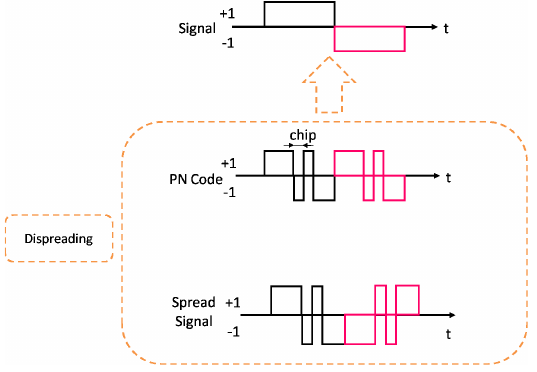
Figure 1: An Example of Mix Network